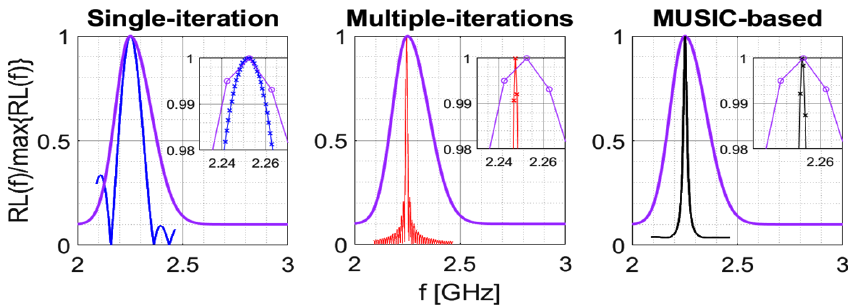
Figure 1. Application example of the three sharpening algorithms under